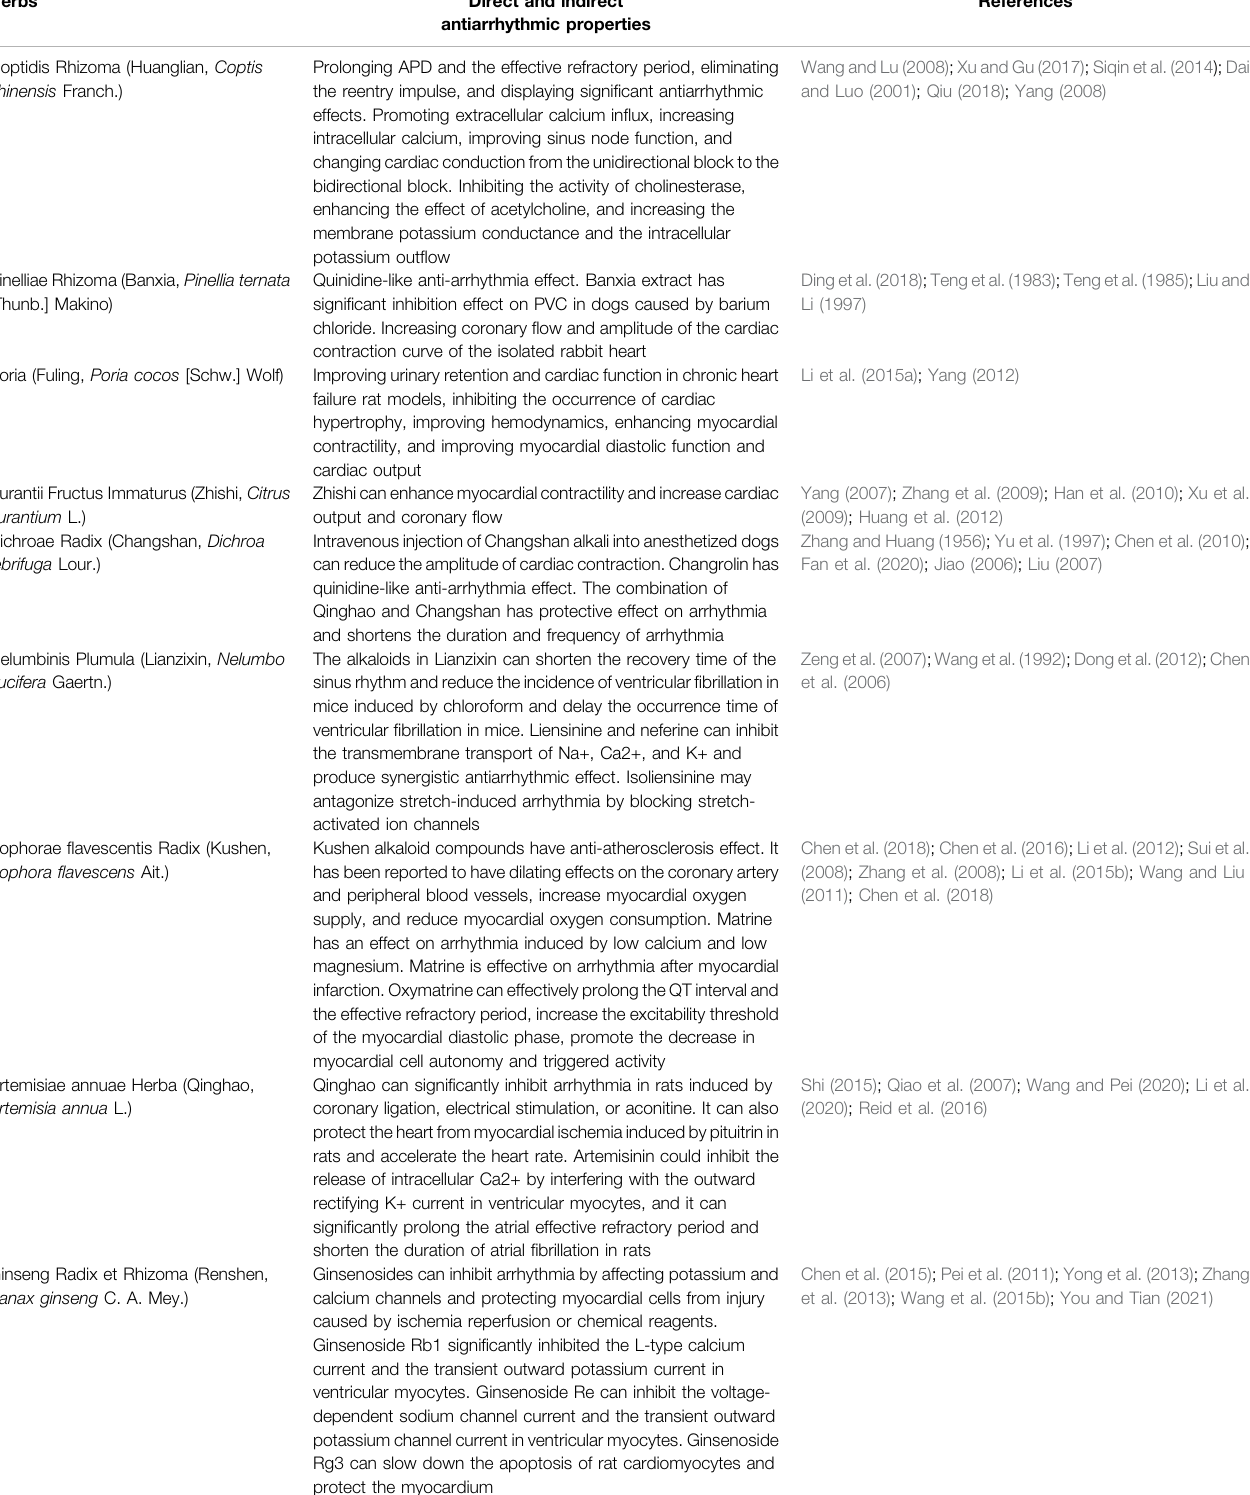
TABLE 2 | Antiarrhythmic properties of the herbal medicines that formulated XSN.